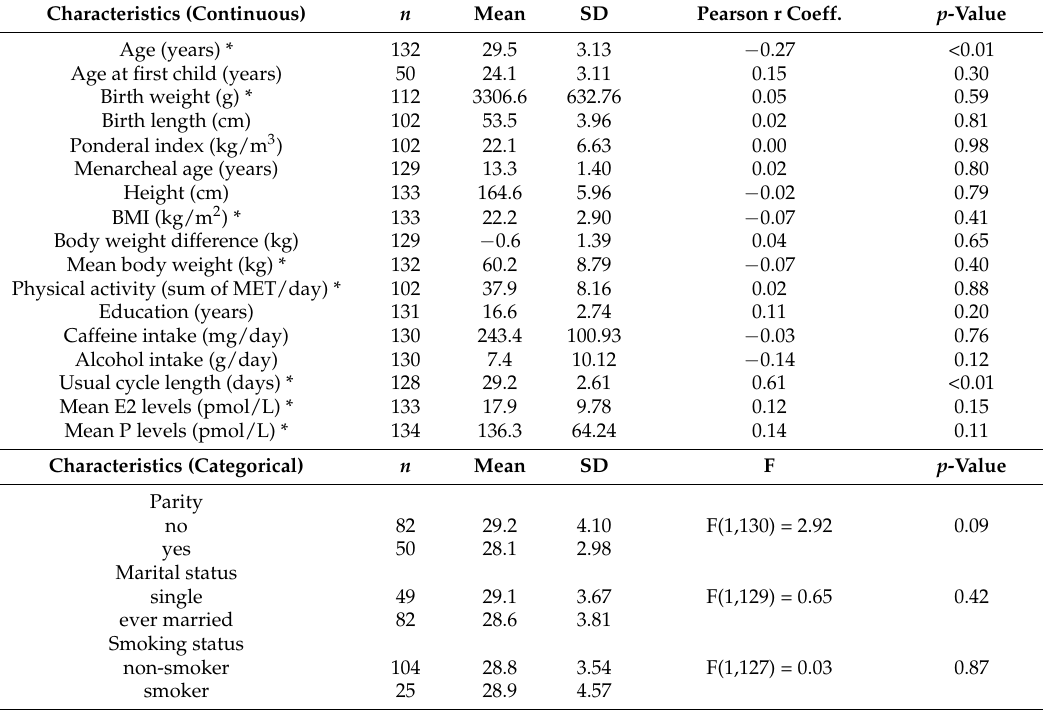
* Pearson correlation test with log-transformed